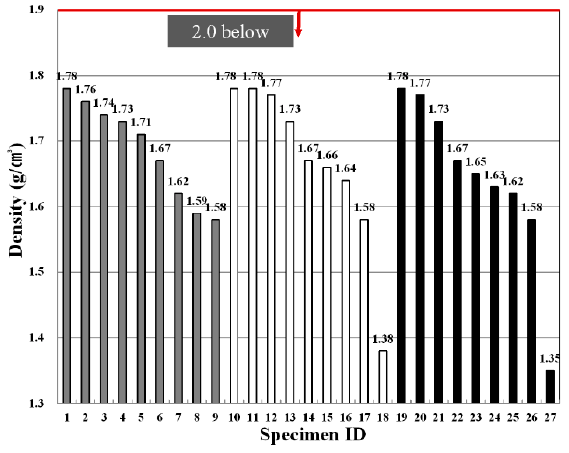
Figure 5. Variation of density for each specimen.